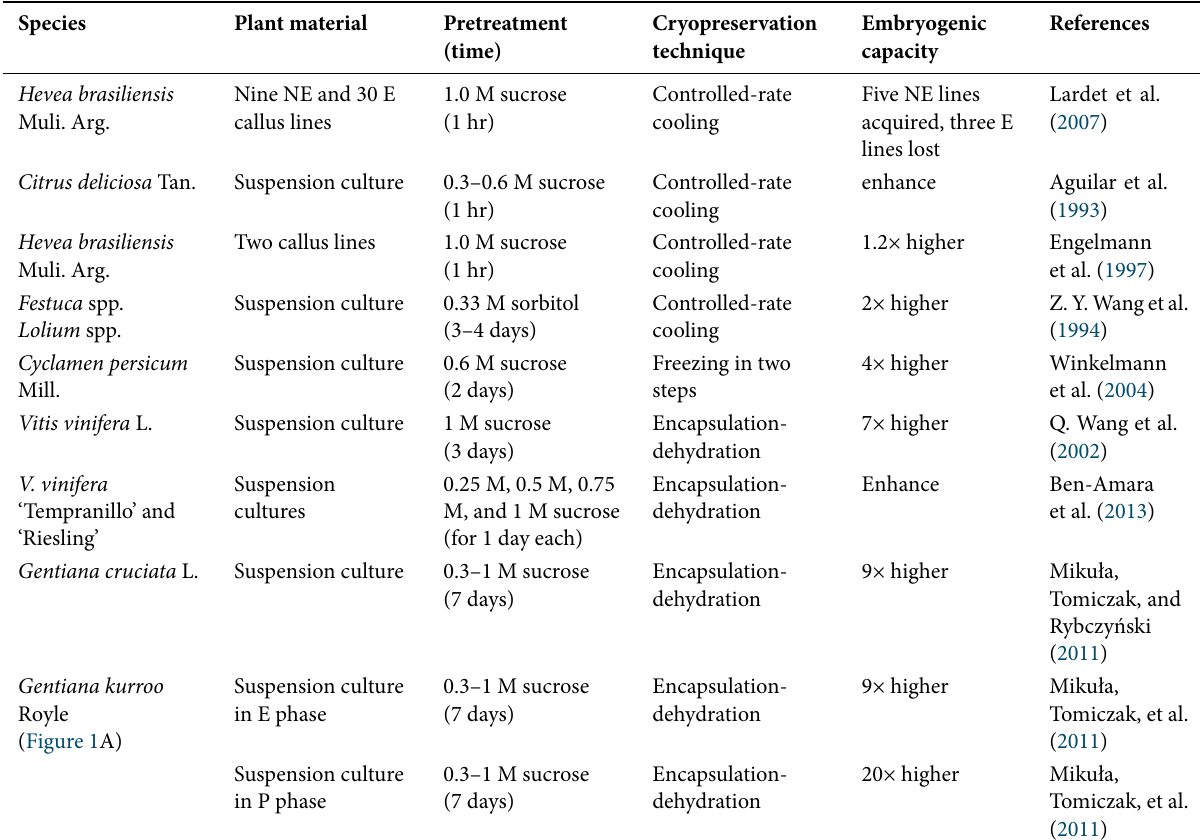
Table 2 Samples of rejuvenation of embryogenic suspension cultures aer cryopreservation in order of increasing embryonic capacity of proembryogenic masses